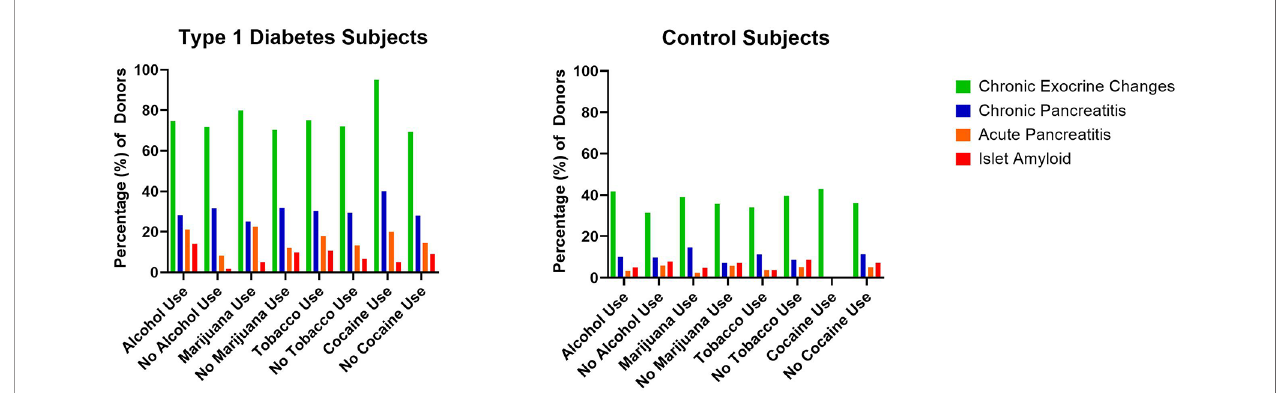
FIGURE 2 | Percentage of type 1 diabetes (n=131) and control (n=111) pancreata from the Network for Pancreatic Organ donors with Diabetes (nPOD) with reported substance versus no substance use and associated